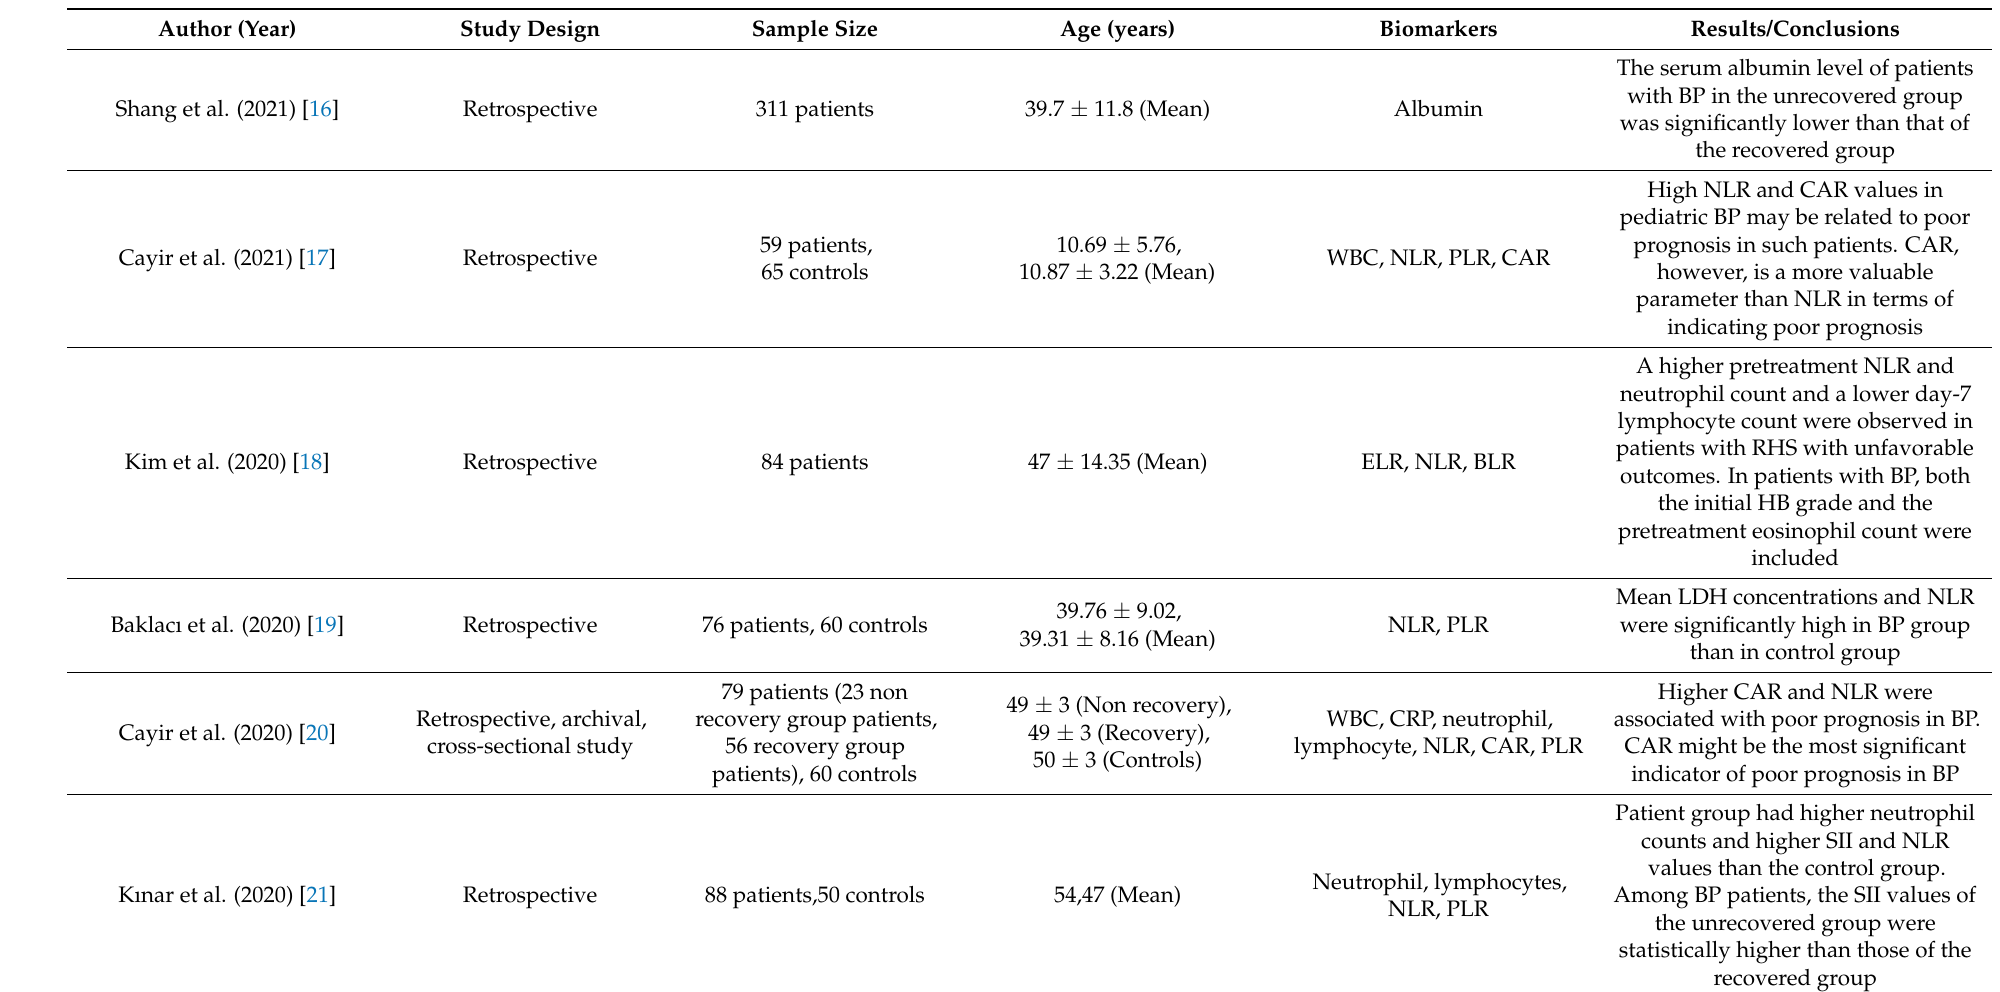
Table 1. Summary of prognostic biomarkers for acute peripheral facial palsy (Inflammatory